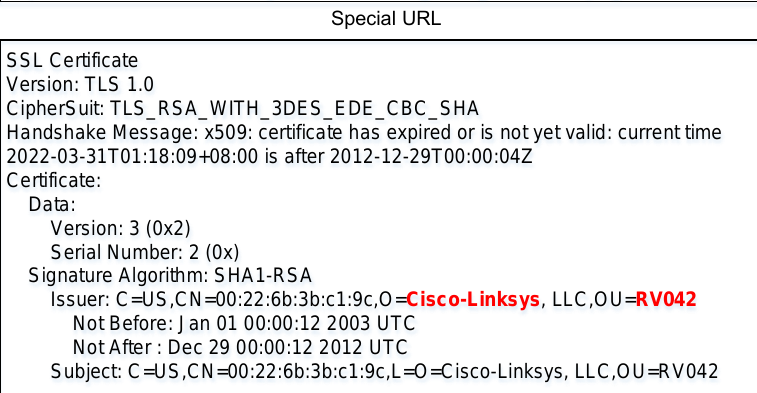
Figure 2. Examples of web